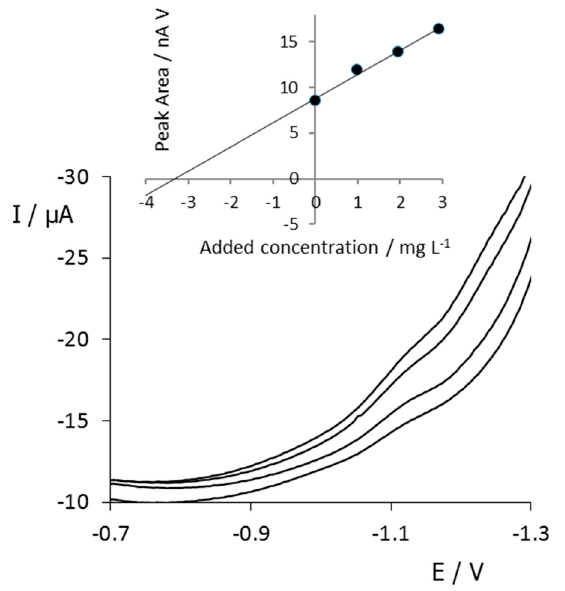
Figure 6. DPV voltammograms measured at pH 2.2 with an SPCNFE of a spiked tap water sample at 3 mg L − 1 BZT and after three standard additions of BZT. The inset shows the calibration plot estimated based on the peak areas. Table 2. Comparison among the theoretical (spiked) concentration of BZT in a tap water sample and that determined with the proposed methodology using SPCNFE. Analyses were performed in triplicate, n = 3.